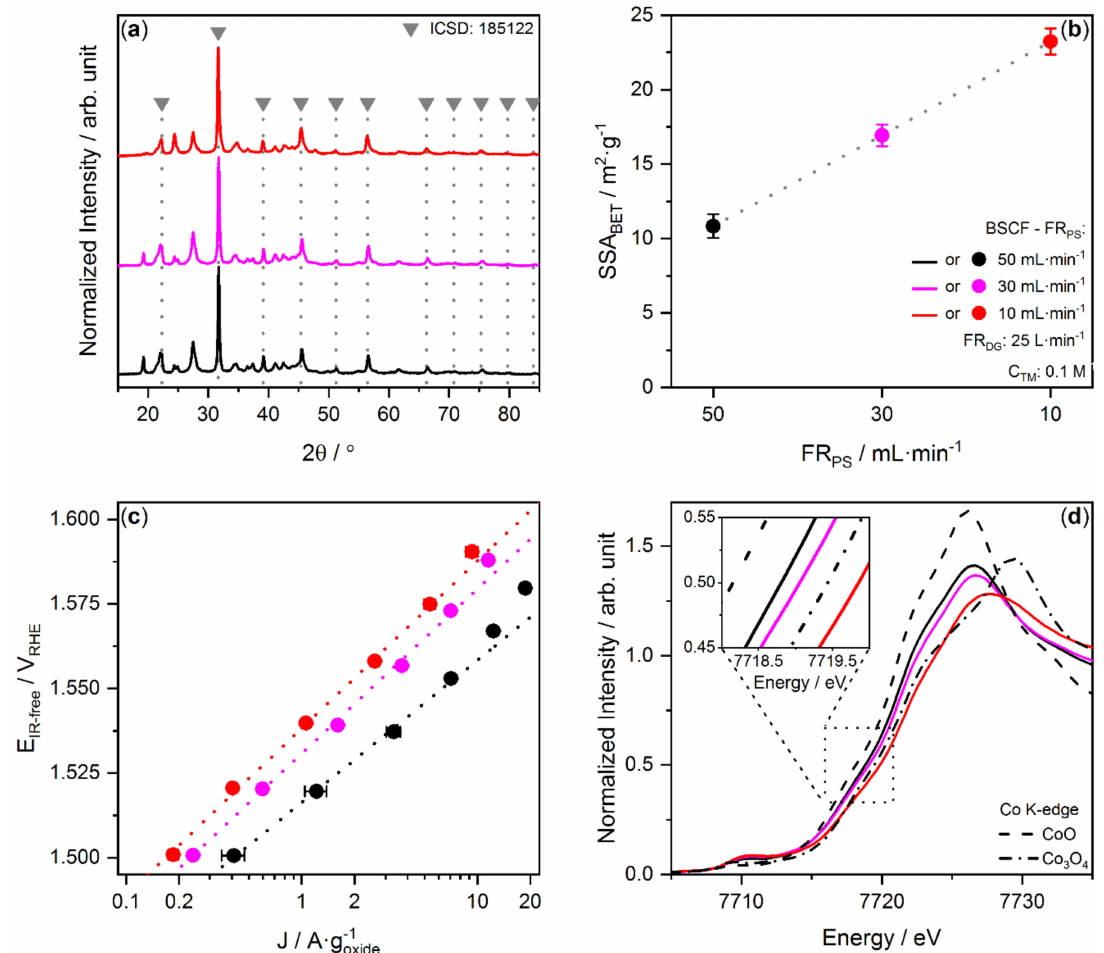
Figure 3. Summary of the influence of the flow rate of the precursor solution (FR PS ) in the range of 50 ( — or • ), 30 ( — or • ) and 10 mL · min − 1 ( — or • ) on flame spray synthesized BSCF: ( a ) Powder XRD patterns ( (cid:72) ICSD reference of BSCF: 185122); ( b ) SSA BET ; ( c ) Tafel plot of the OER activities with linear fit (dotted line); ( d ) Co K-edge XANES spectra of the as-synthesized BSCF batches (standards: CoO ( – – ) and Co 3 O 4 ( – • – )). For all cases: FR DG = 25 L · min − 1 and C TM = 0.1